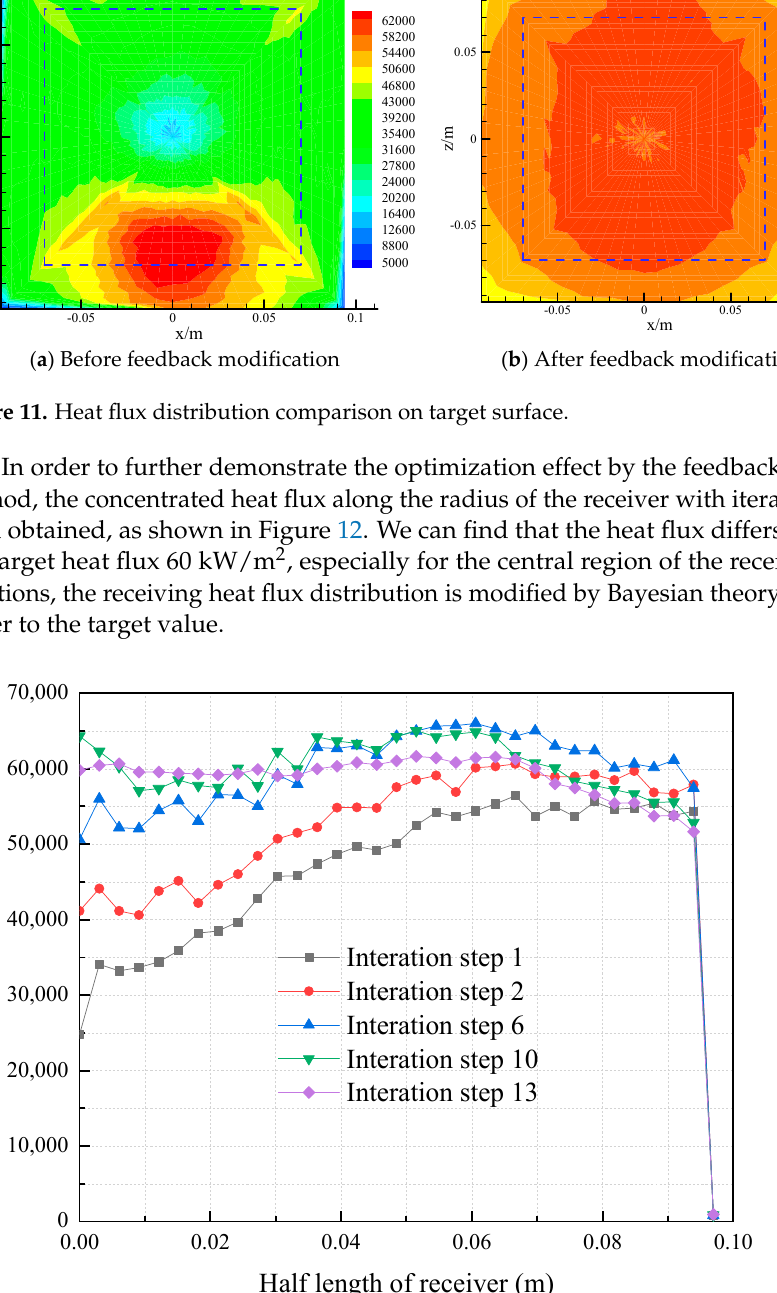
Figure 12. Concentrated heat flux along the radius of receiver with iteration steps. The corresponding different target distributions and the heat flux distributions after optimization are shown in Figure 13. Both the 2-D projected section and the 3-D distribution have been provided. The black lines represent the corresponding target distribution. Figure 13a is the Gaussian distribution with E 0 ( r , ϕ ) = 80, 000 exp ( − r 2 / ( 2 σ 2 )) of the target heat flux, where σ = 0.05. Figure 13b is the uniform distribution with a target heat flux of 60,000 W/m 2 . Figure 13c is the concave distribution with a target heat flux E 0 ( r , ϕ ) = 100, 000 − 60, 000 exp ( − r 2 / ( 2 σ 2 )) , where σ =